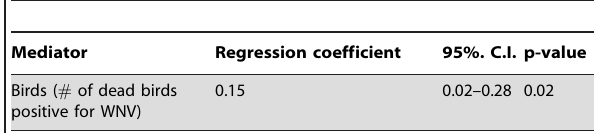
Table 3. Instrumental variable analysis showing the association between WNV human cases and WNV bird deaths with precipitation and hydrogeographic area as